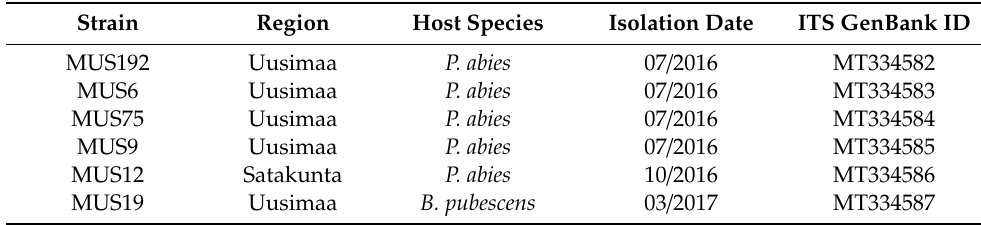
Table 4. Ganoderma lucidum